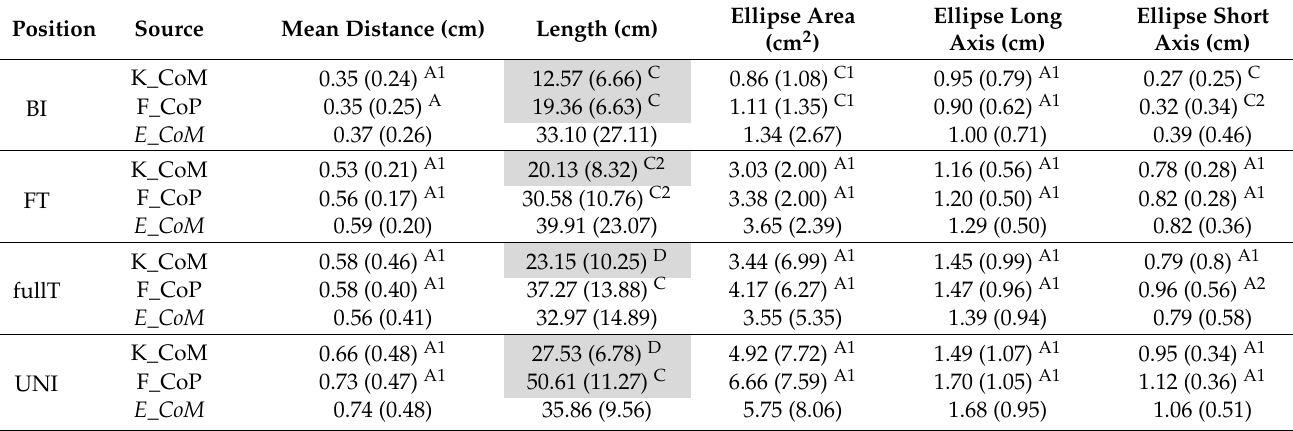
Table 6. Descriptive and reliability statistical results of the two-dimension parameters for the Equimetrix CoM ( E _ CoM ) comparison with the kinematic CoM (K_CoM) and force platform CoP (F_CoP). Parametric data is expressed as Mean ± Standard-deviation, while non-parametric data is express as Median (Inter-quartile